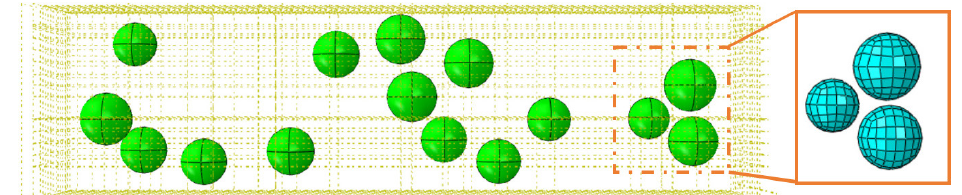
Figure 2. Diagram of TiC particle splitting.